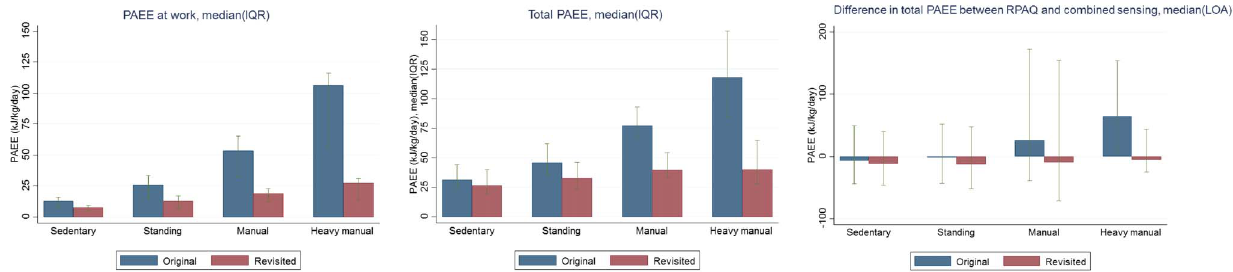
Figure 2. Total PAEE and PAEE at work derived from the RPAQ, and bias for total PAEE before and after applying intensity distribution assumption. Results are based on the‘‘holdout sample’’, with the following number of participants in each category: sedentary N=264, standing N=147, manual N=58, heavy manual N=12, representing 1/3 of participants in each group of the employed participants. Data are median (IQR), and median with 95% limits of agreement for